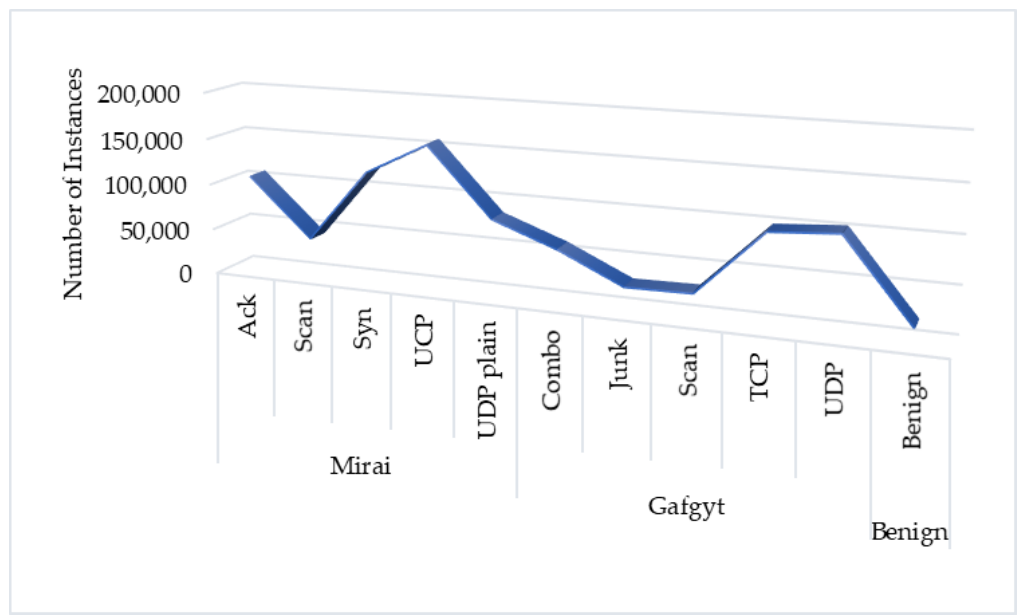
Figure 2. The distribution of the dataset.